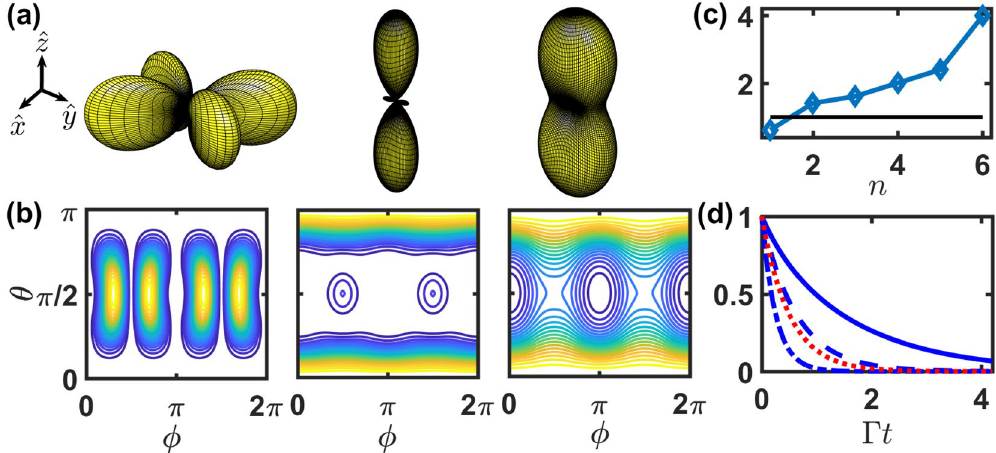
Figure 2. The far-field Ω f ( θ , φ ) of ˆ x -polarized HPI two-photon states for four atoms on a ring. ( a ) Three- dimensional plots of Ω f ( θ , φ ) at r / λ = 0.2 with l = 1, 2 and 4, respectively. Corresponding two-dimensional plots are shown in ( b ). ( c ) The spontaneous decay rates, Re [ − λ n ]/( Γ /2) in an ascending order, are numerically calculated from the eigenvalues λ n for this given atomic configuration. A horizontal line guides the eye for natural decay rate Re [ − λ n ] = Γ /2. ( d ) The fluorescence intensity I 0 (t) of the HPI two-photon states with l = 1 (dash), 2 (solid), and 4 (dash-dot), compares with e − 2 Γ t